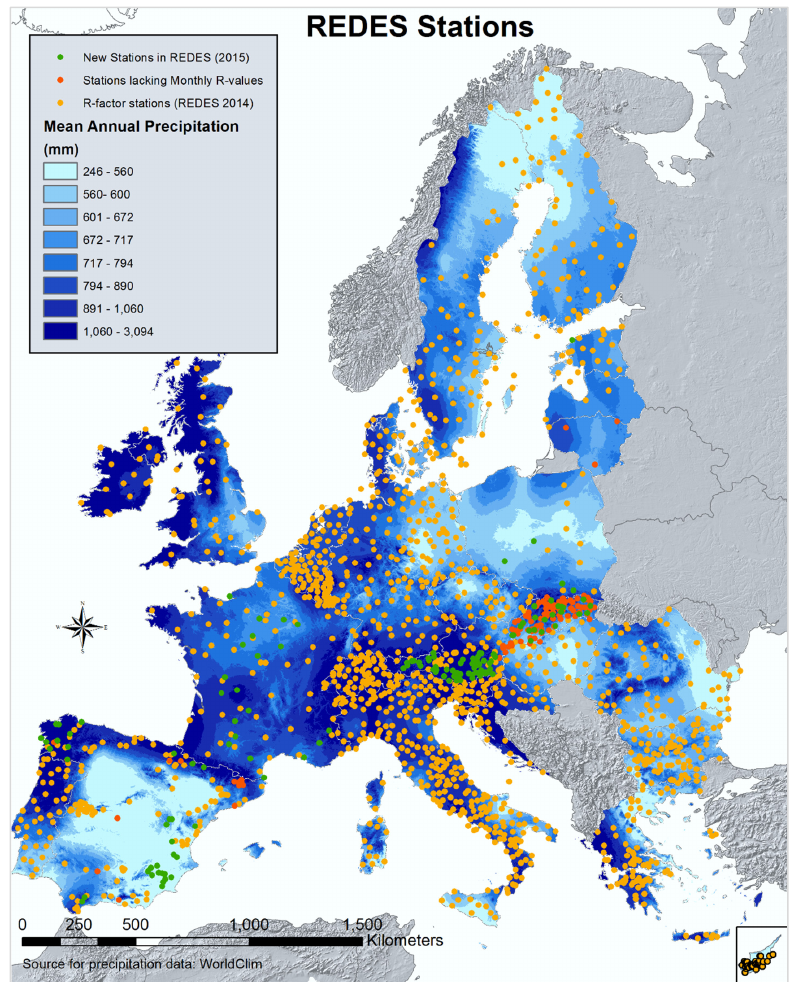
Figure 1. Rainfall stations included in the Rainfall Erosivity Database on the European Scale (REDES) (In green color, the new stations added to REDES (2015); in red color, the stations lacking monthly R-factor values, in yellow color, REDES (2014)).